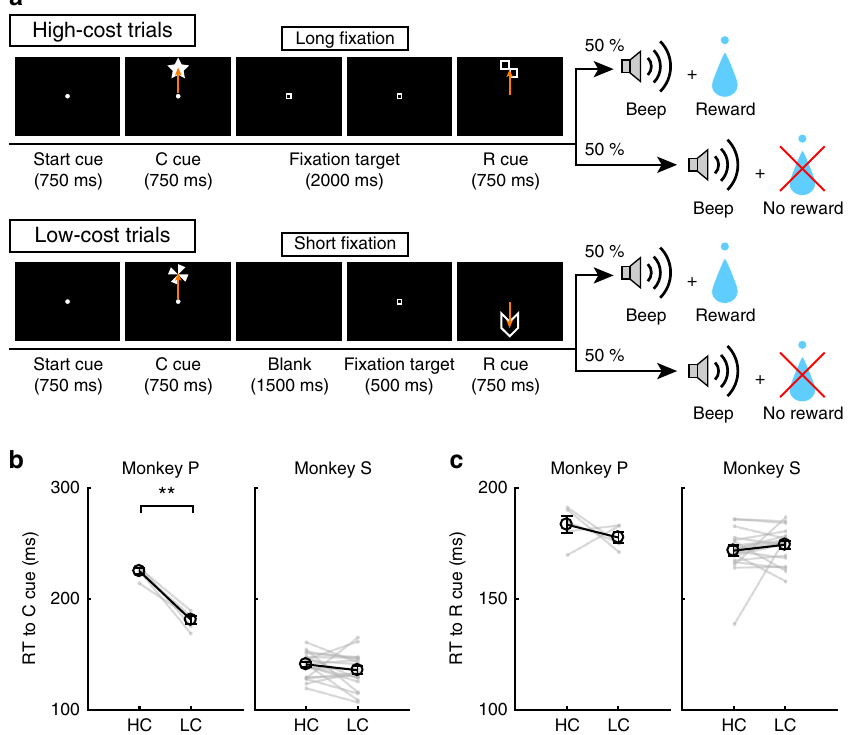
Fig. 5 HLC uncertain task. a The HLC uncertain task. In this task, uncertain reward cues, in which rewards were delivered 50% of the time irrespective of which cue was presented, were used. b RTs to the cost cues in the high-cost and low-cost trials. Only monkey P showed a faster RT to the LC cue than the HC cue (** P < 0.01; two-tailed paired t test; t 4 = 9.0, P = 8.5 × 10 − 4 , n = 5 for monkey P; t 18 = 1.4, P = 0.19, n = 19 for monkey S). Black circles and error bars indicate mean and SEM. c RTs to the reward cues in the high-cost and low-cost trials. There was no difference in the RTs to the reward cues between the high-cost and low-cost condition (two-tailed paired t test; t 4 = 0.97, P = 0.39, n = 5 for monkey P; t 18 = 0.99, P = 0.39, n = 19 for monkey